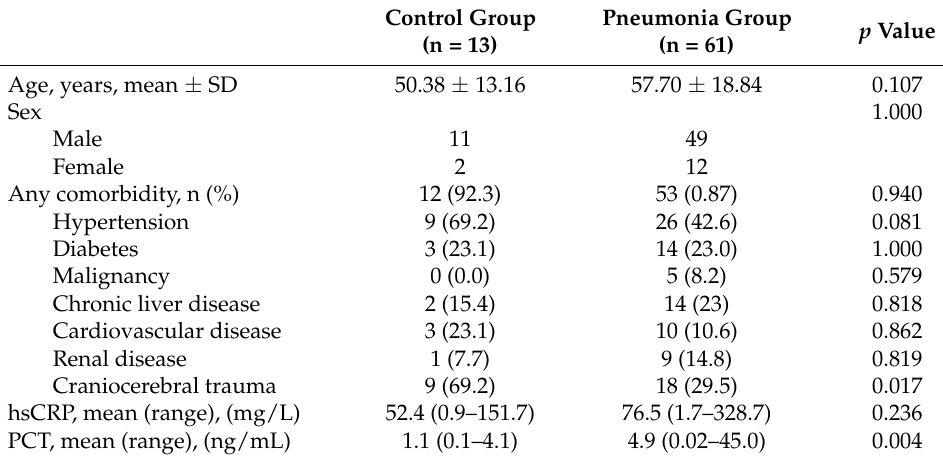
Table 1. Demographic and baseline characteristics of